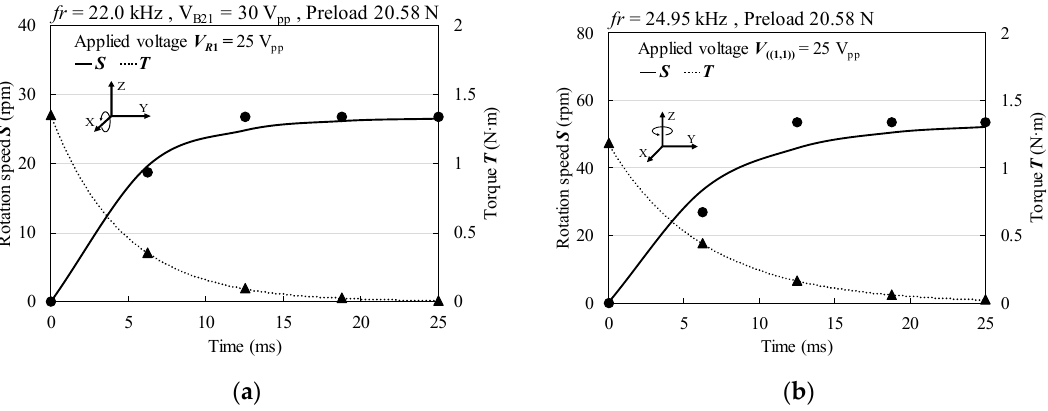
Figure 18. Transient response of rotation speed and torque with preload of 20.58 N. ( a ) Rotation around X(Y)-axis; and ( b ) Rotation around Z-axis.